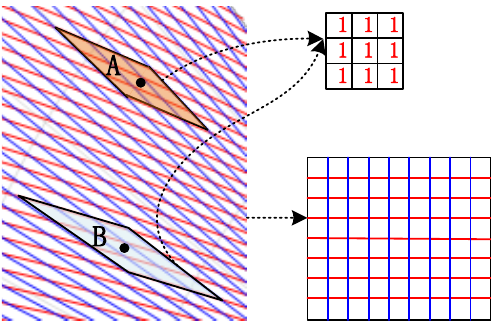
Figure 5. The sketch map of the grid projection.